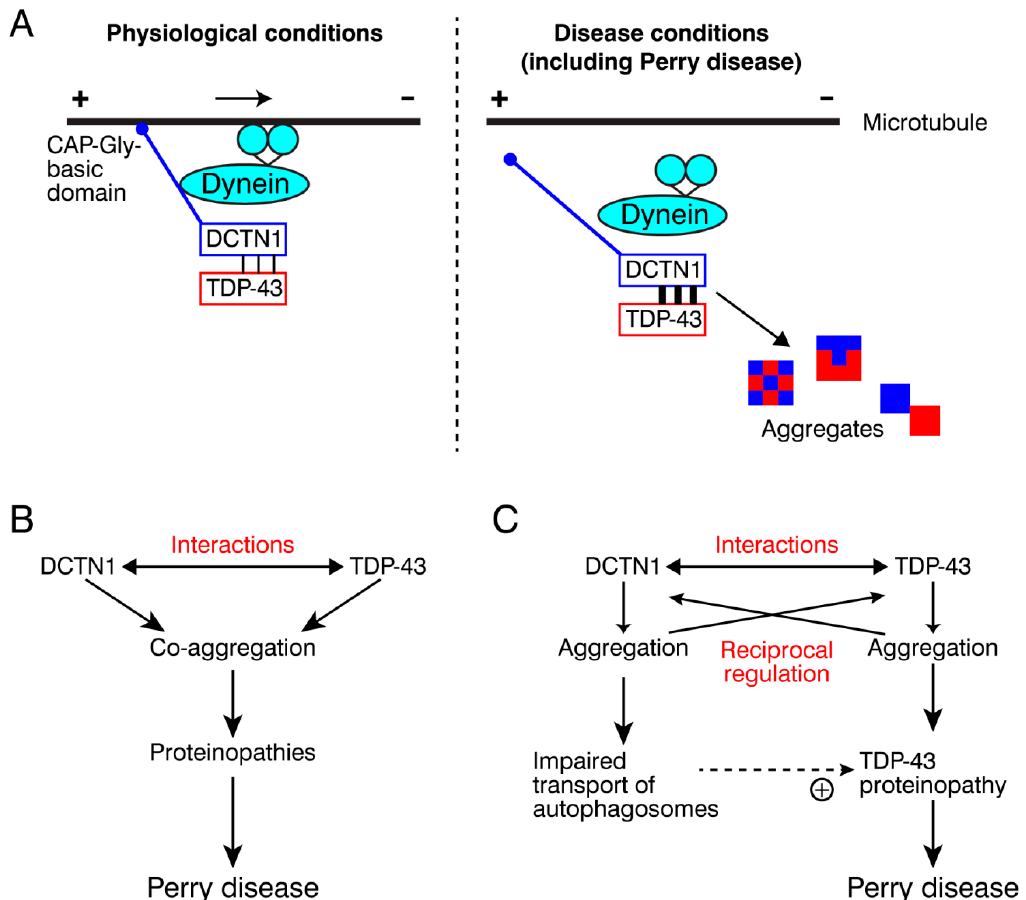
Figure 7. Models for DCTN1 function in TDP-43 cytoplasmic-nuclear transport in health and disease. ( A ) A model for physiological mechanisms of the dynein–dynactin-mediated retrograde transport of TDP-43 along microtubules and pathological mechanisms triggering TDP-43 aggregation in disease conditions, including Perry disease. ( B , C ) Two possible, but not mutually exclusive, models of pathological mechanisms that may cause Perry disease (see text).